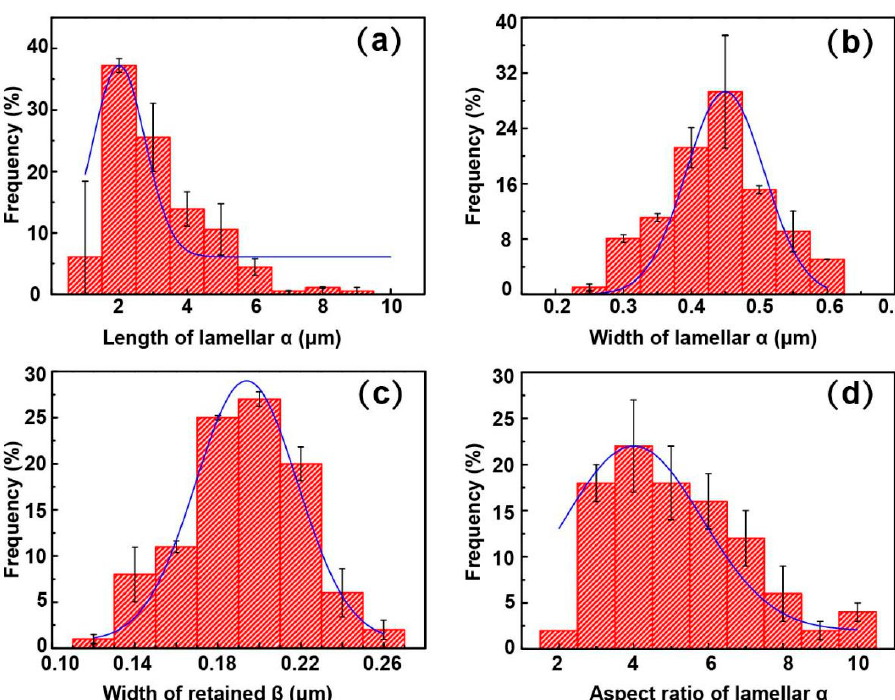
Figure 6. Distribution of microstructural features of TC4F Sample 2 after treatment. ( a ) Length of lamellar α , ( b ) width of lamellar α , ( c ) width of retained β , and ( d ) aspect-ratio distribution of lamellar α . Microstructural features followed Gaussian distribution. Most probable values of α length, width, aspect ratio, and retained β were ~3, ~0.9, ~3, and ~0.25 μ m, respectively.